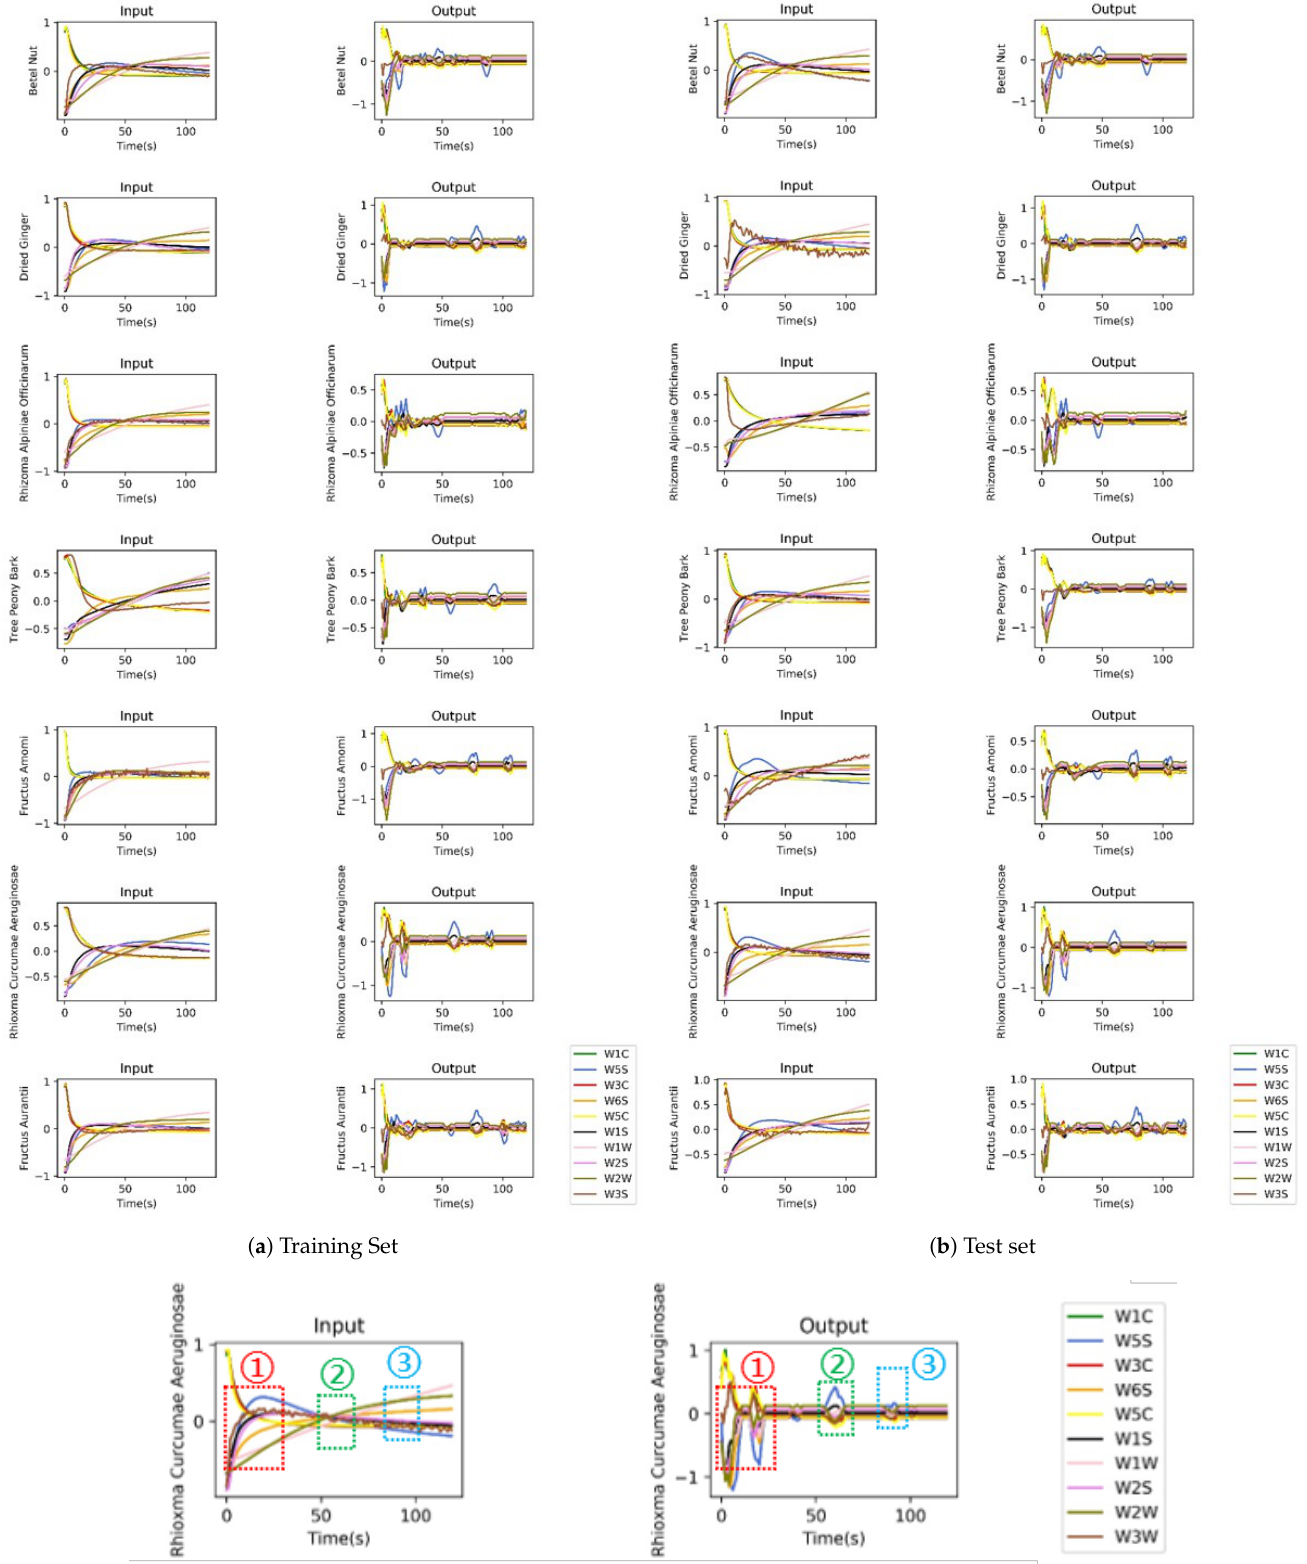
Figure 6. The original responses and decoded responses. In ( a , b ), the left column shows the input responses of OLCE encoder, and the right column describes the output responses of OLCE decoder. The subfigure ( c ) highlights the significant features extracted by